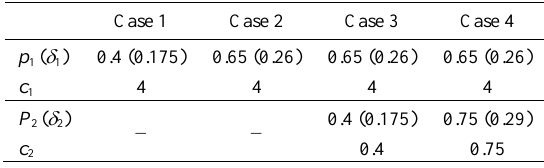
Damage cases, cuts dimensions [mm] and damage parameter